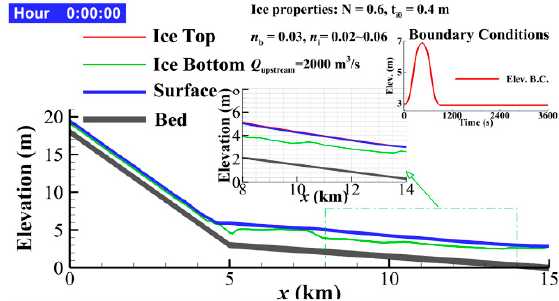
Figure 8. Initial flow and ice conditions in a slope-varying channel .